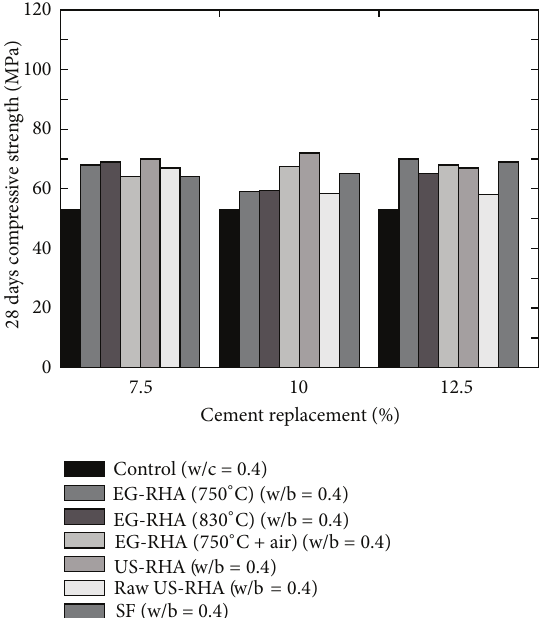
Figure 16: Effect of Egyptian RHA (EG-RHA) containing low car- bon obtained at a different combustion temperature on the com- pressive strength of concrete